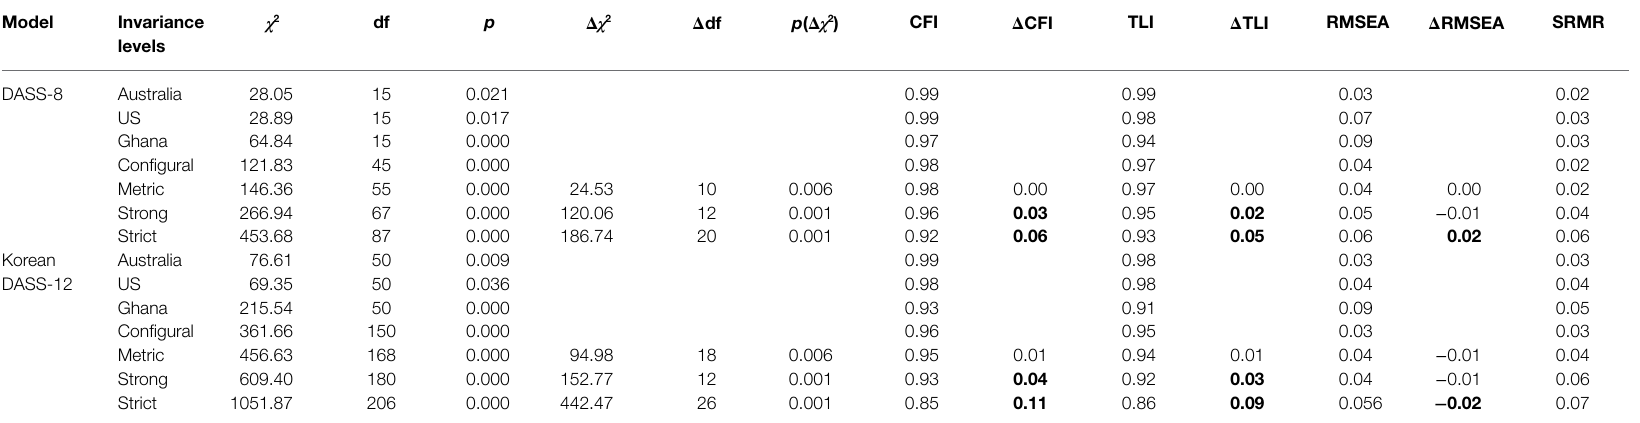
TABLE 2 | Invariance of factor structures of the Depression Anxiety Stress Scale 8 (DASS-8) and DASS-12 across countries. Model Invariance levels DASS-8